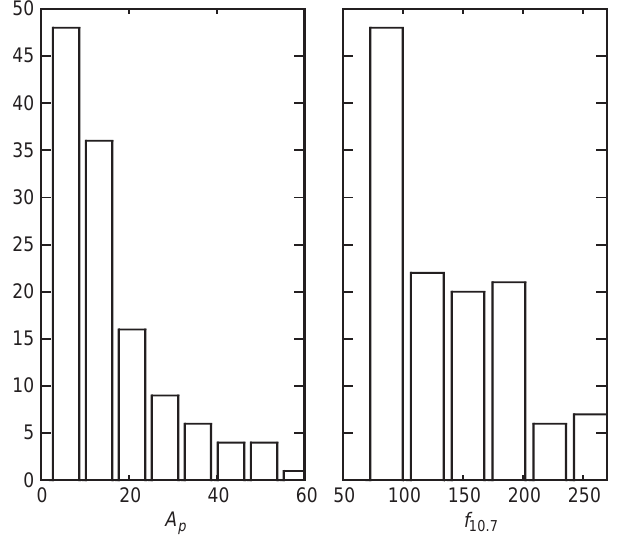
Fig. 1. Distribution of A